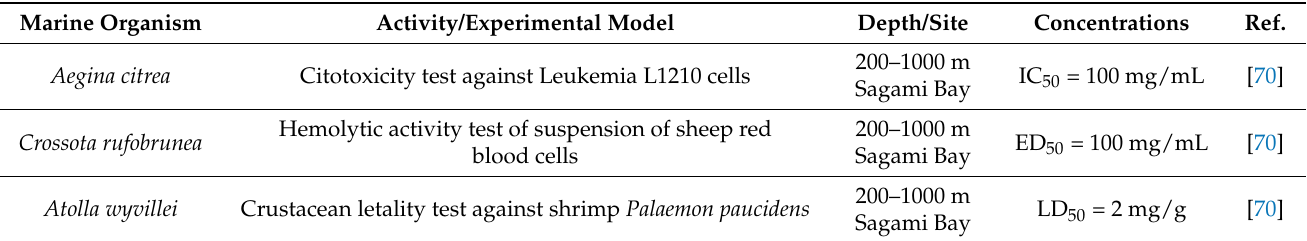
Table 3. Bioactive compounds from deep-sea